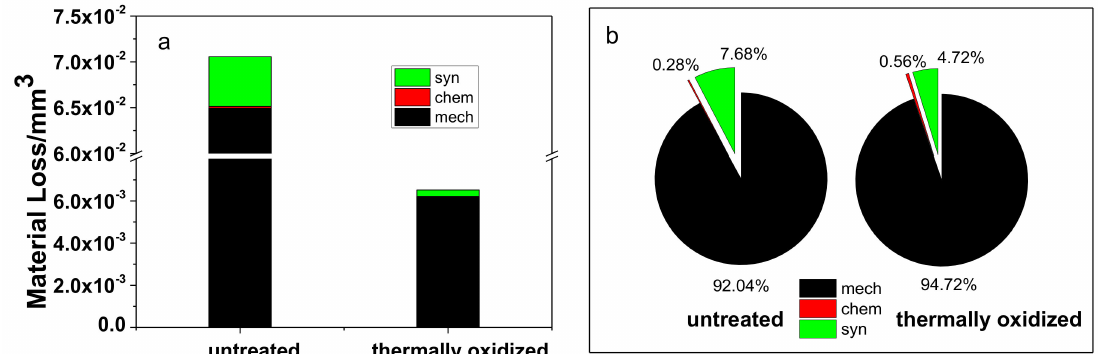
Figure 9. The ( a ) bar chart and ( b ) pie chart of Table